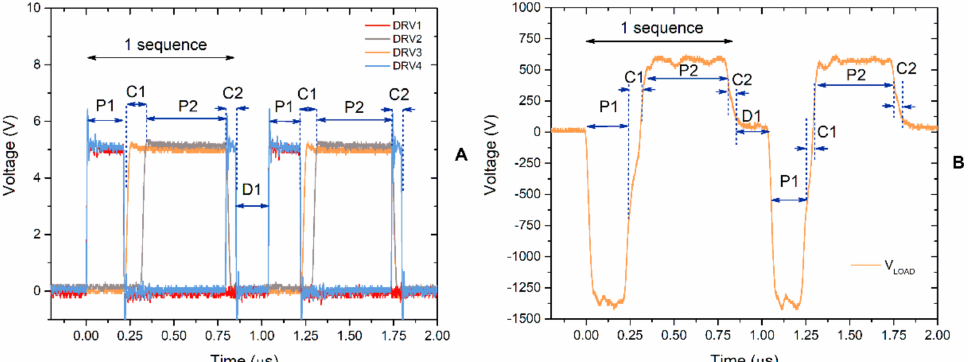
Figure 4. The output waveforms of a 4-channel driver ( A ) and the output pulse on the load ( B ), where P1 and P2 are 200 and 500 ns pulses, respectively; C1 and C2 are the crowbar pulses (sub-100 ns) and D1 is the preprogrammed delay between sequences, which is in this case equal to 190 ns; R LOAD = 1 k Ω